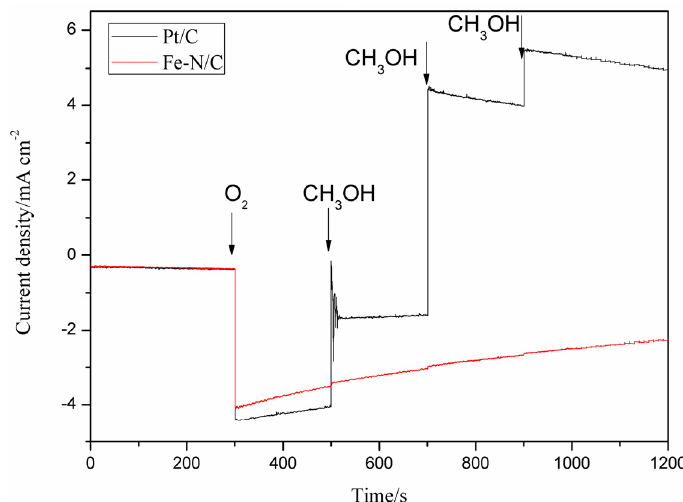
Figure 4. Amperometric current-time curves of Fe–N/C and Pt/C in N 2 -saturated 0.1 M KOH solution under magnetic stirring (600 rpm) and N 2 -protection from 0 to 300 s, followed by immediate introduction of O 2 . The applied potential is − 0.1 V. The arrows indicate the sequential addition of 5.0 M methanol.